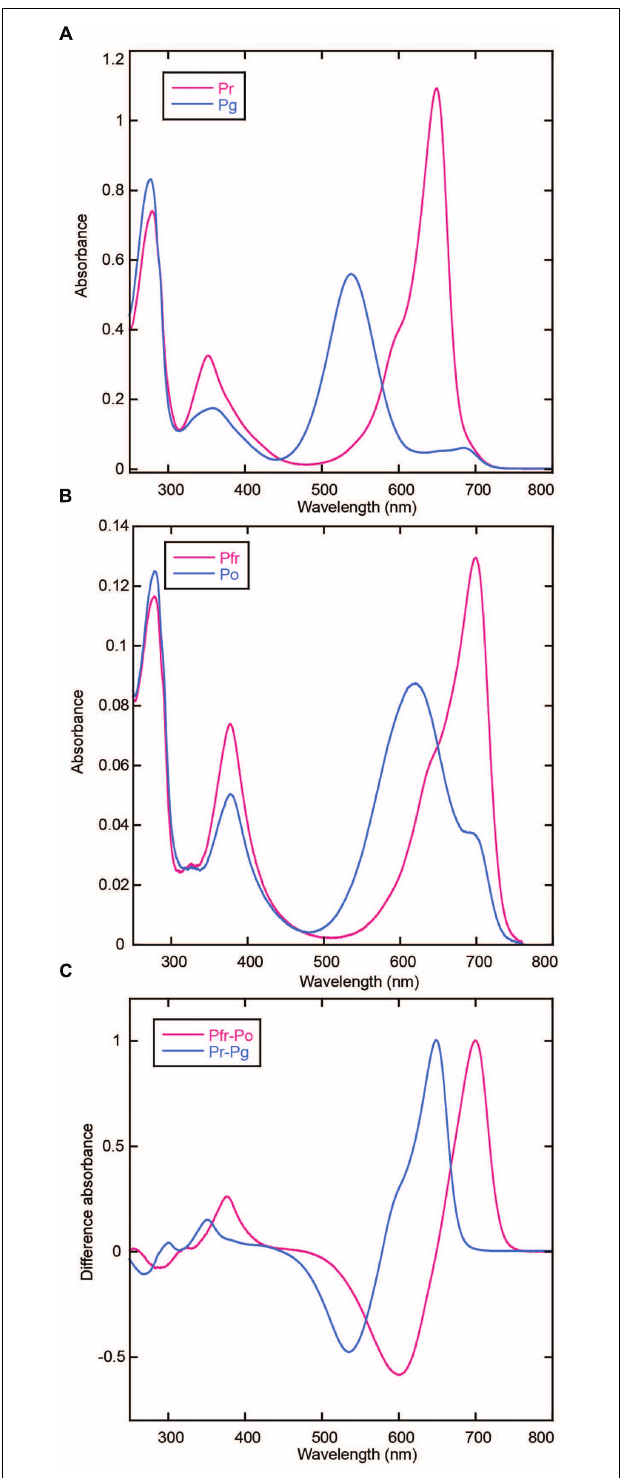
FIGURE 2 | Photoconversion of AM1_C0023g2-PCB and AM1_C0023g2-BV. (A) Absorption spectra of Pr (magenta) and Pg (blue) forms of AM1_C0023g2-PCB. (B) Absorption spectra of Pfr (magenta) and Po (blue) forms of AM1_C0023g2-BV. (C) Difference spectra of PCB- (blue) and BV-binding (magenta) AM1_C0023g2 before and after